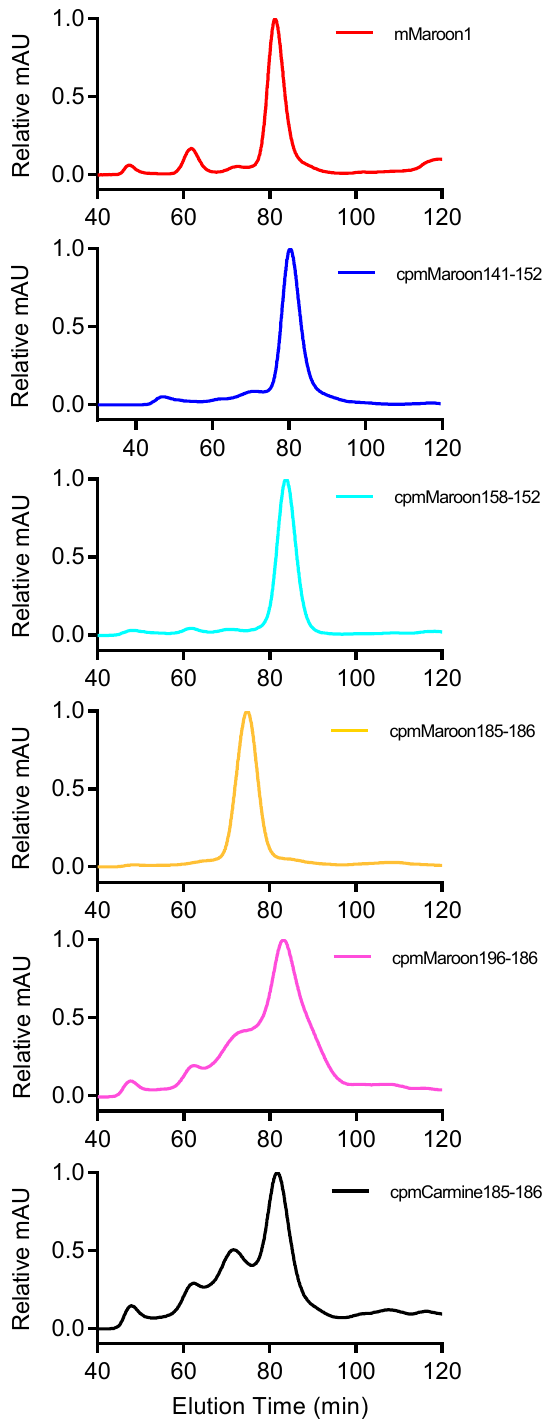
Figure 5. Gel filtration chromatography elution profiles of different variants. The absorbance detection was at 280 nm. The graphs from upper to lower are for mMaroon1, cpmMaroon158-152, cpmMaroon196-186, cpmMaroon185-186, cpmMaroon141-152 and cpmCarmine185-186.